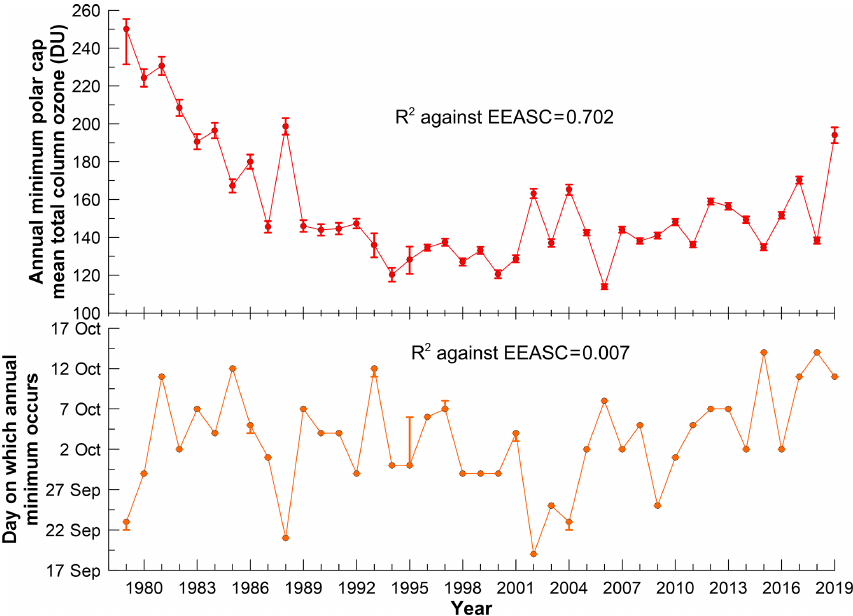
Figure 8. Annual minima in the daily polar cap mean TCO time series and the dates on which those minima occurred. Error bars show the ± 1 σ uncertainties, which are often